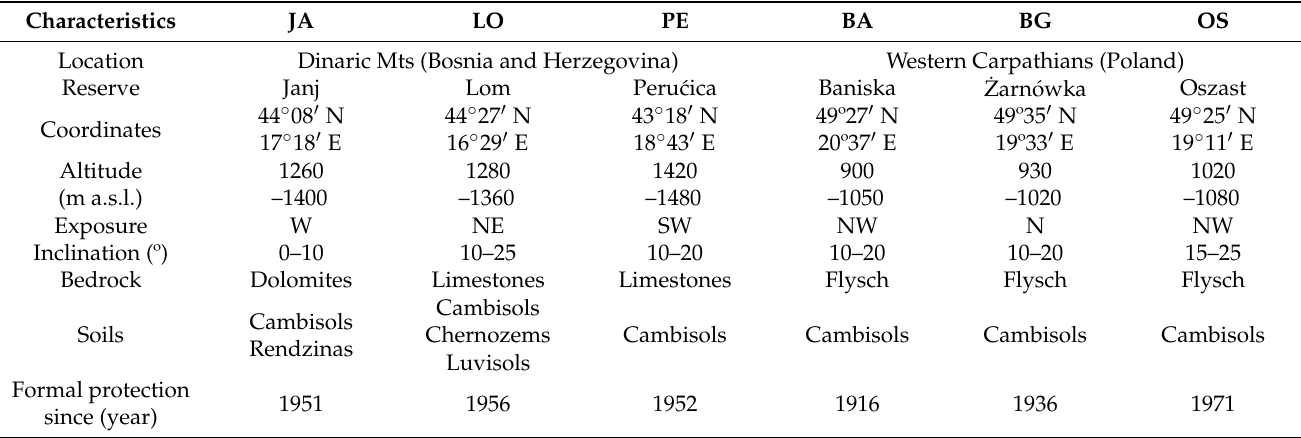
Table 1. Site characteristics of the studied